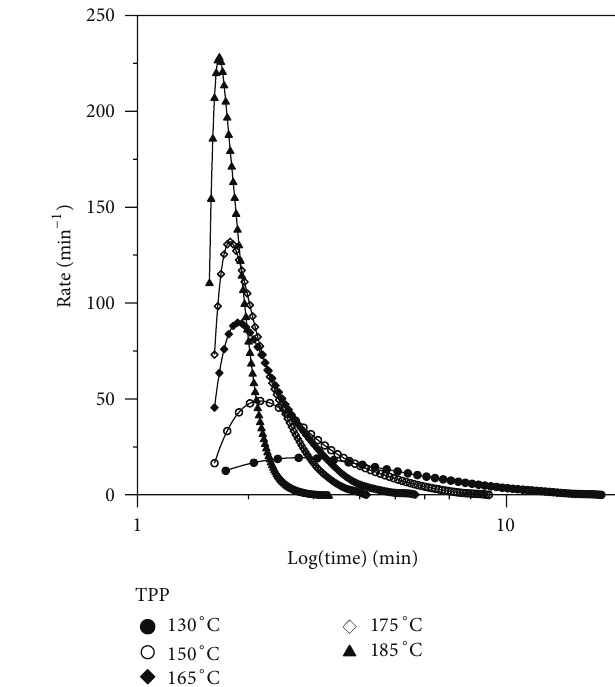
Figure 2: Plots of the reaction rate versus time for TPP-cured EMCs at isothermal